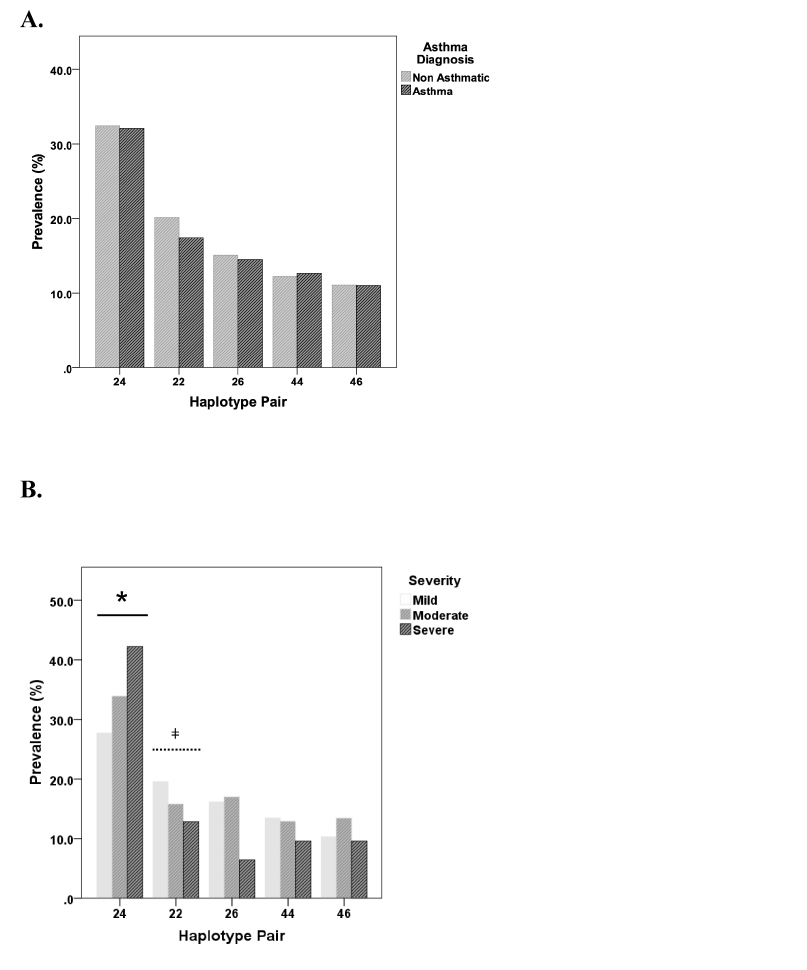
Figure 2. Comparison of prevalence of ADR b 2 haplotype pairs with (A) asthma diagnosis (n=2979) and (B) asthma severity (n=683). The most common haplotype pair 2/4 was associated with severe asthma (Trend test, OR 1.42, p=0.0008).